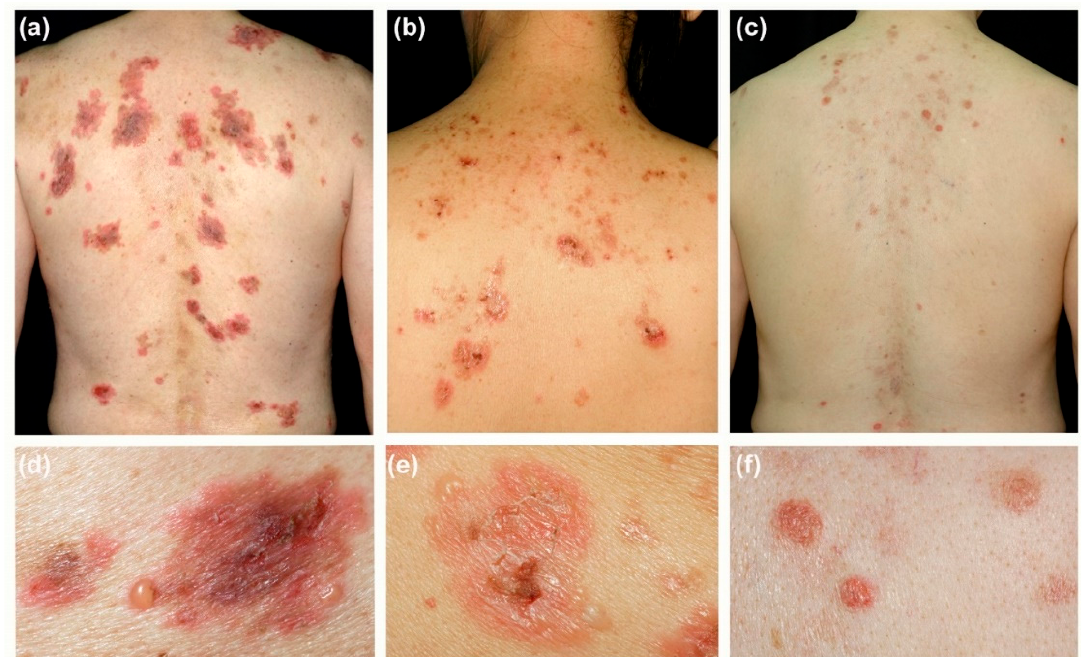
Figure 1. Clinical images of representative patients with IgG/IgA pemphigus. ( a , b , d , e ) Annular or arciform erythematous patches with vesicles, pustules, or crusted wounds found in some patients. ( c , f ) Other patients may present with discrete erythematous eroded macules or patches similar to those in conventional pemphigus.